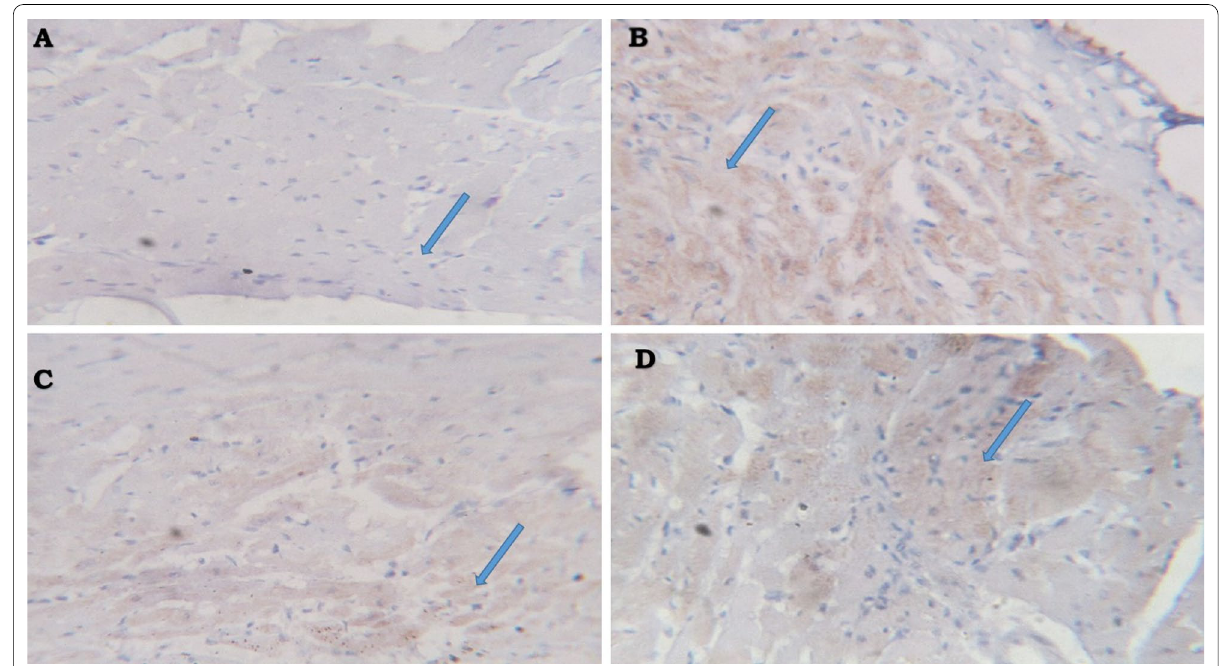
Fig. 4 Photomicrons A–D are group representative photographs of GLUT4 cardiac tissue expression in rats ( immunohistochemical staining in control. B represents immunohistochemical staining in salt-induced insulin-resistant group of rats. C represents immunohistochemical staining in sucrose-induced insulin-resistant group of rats. D represents immunohistochemical staining in high fat-induced insulin-resistant group of